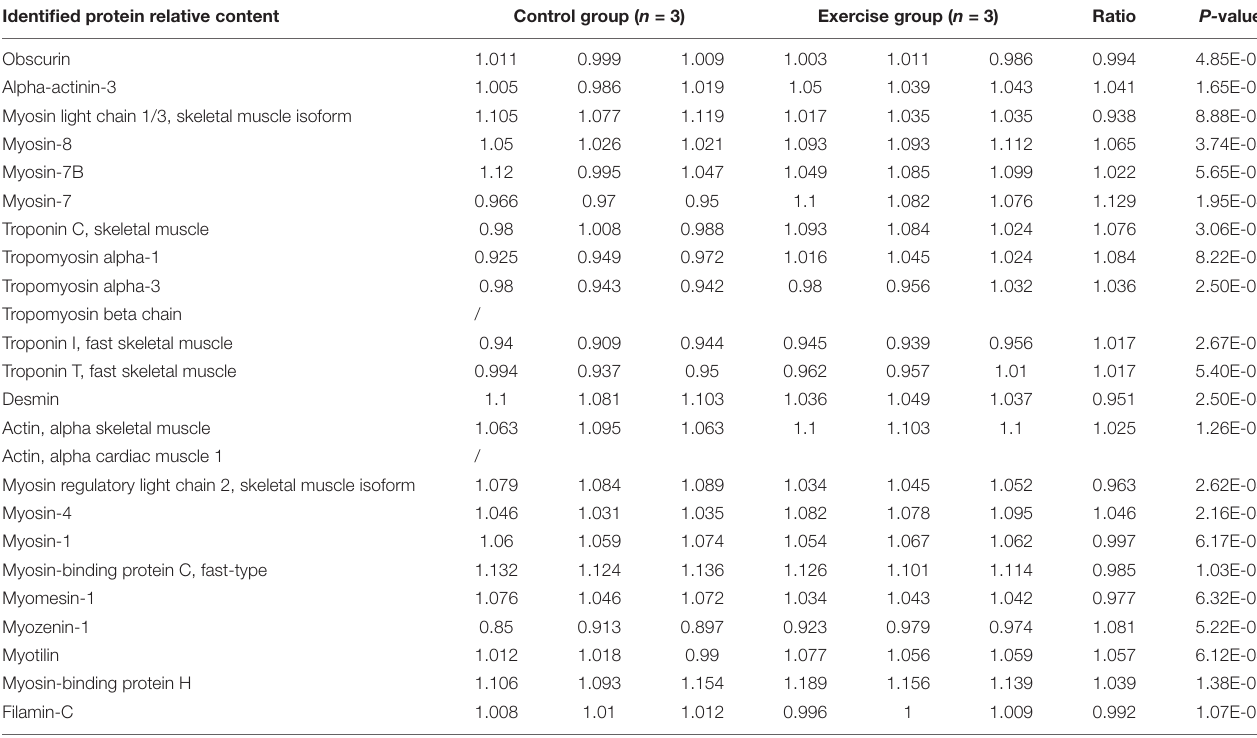
Protein (peptides) relative content was measured in muscle samples of mice from the control group and exercise group, n = 3 mice/group. Student’s t-test was used in SPSS; there were no significant differences between the two groups. Data about titin were shown in Huang’s study (Huang et al., 2020). Although tropomyosin beta chain and actin alpha cardiac muscle 1 were identified, we did not get its quantitative information. Information about acetylated lysine sites of protein in muscle sarcomere. Modified sequence: identified peptide sequence marked with modification sites’ localization probabilities and amino acid types of all sites is K (Lysine). Protein accession: the identifier of protein in UniProt. Positions: modification site localization in protein. PEP: the maximal posterior error probability for peptides. Ratio: the acetylation fold- change ratio of identified lysine sites. Score: the − 10 logarithmic probability of observing the given number of matches or more by chance. Student’s t-test was used in SPSS. Data about titin were shown in Huang’s study (Huang et al.,